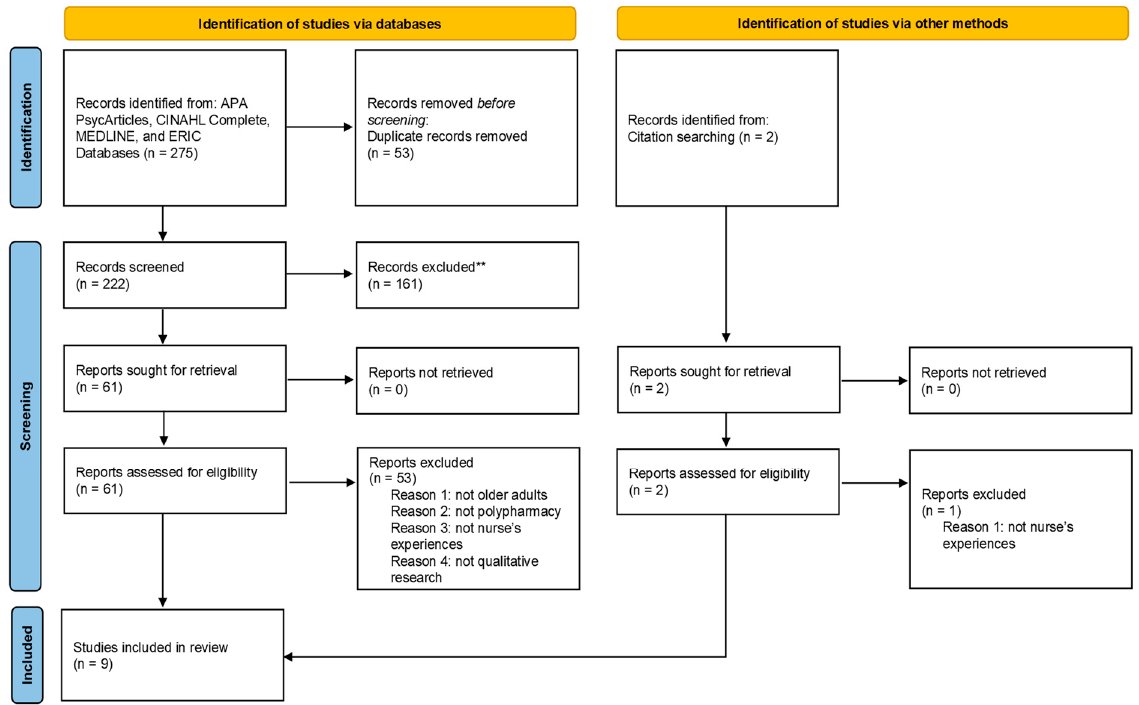
Figure 1. The PRISMA flow diagram illustrating the study selection process. A primary search across five electronic databases yielded 275 records. After removing duplicates, 222 were screened for inclusion; 161 records were excluded based on their titles and abstracts. The remaining 61 records were retrieved and reviewed in full text for eligibility. After a full-text review, 8 records were eligible, and 53 were excluded according to the exclusion criteria. One record was identified through citation searching.